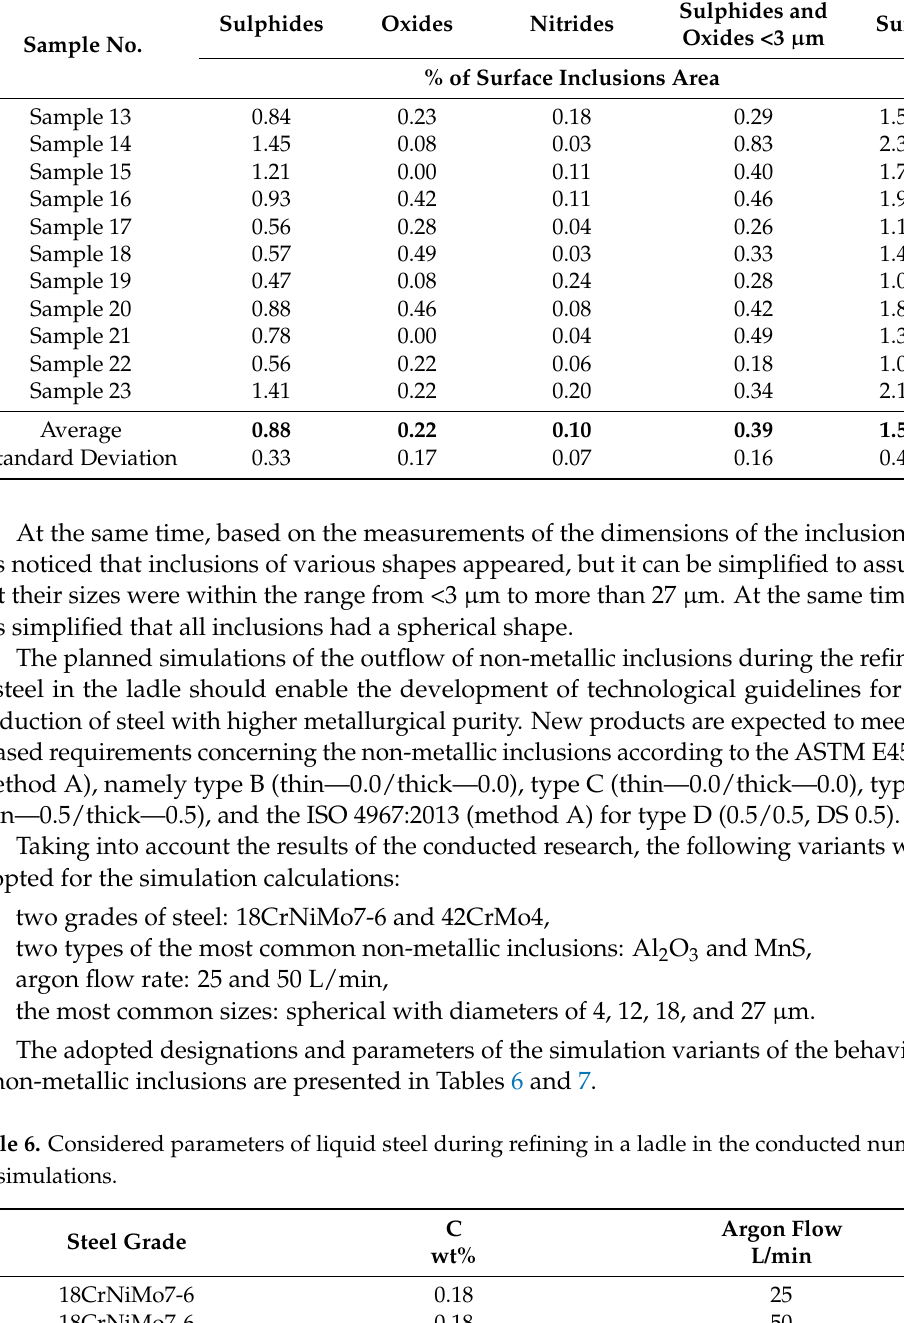
Table 5. Results of research on the quantitative distribution of inclusions in 42CrMo4 steel. Sulphides Oxides Nitrides Sample No.